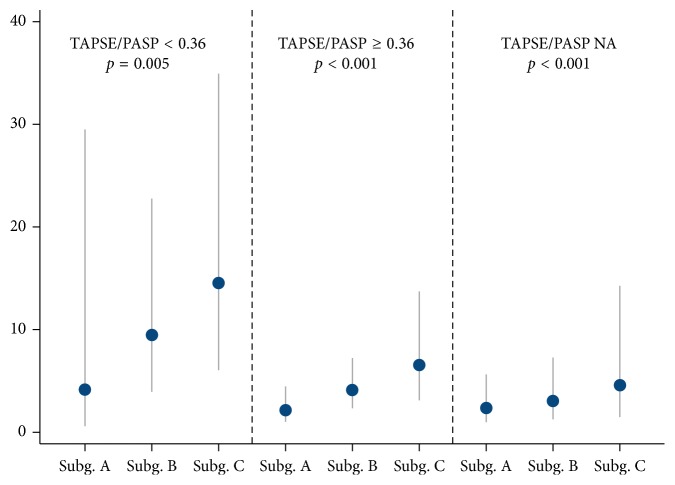
Predefined subgroup analysis: mortality rates per number of biomarkers and TAPSE/PASP categories (p for interaction = 0.24). Subgroup A (Subg. A): both biomarkers below the threshold; subgroup B (Subg. B): 1 biomarker above the threshold; subgroup C (Subg. C): 2 biomarkers above the threshold.